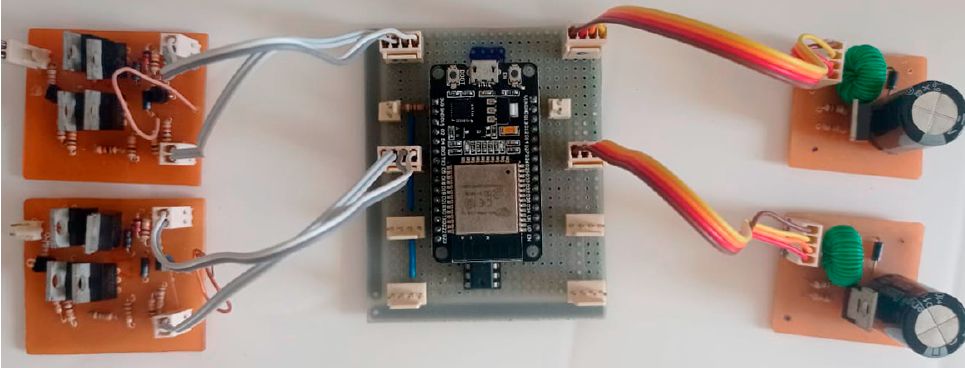
Figure 6. Electrostimulation built circuit. The figure shows the 2-channel circuit of the developed electrostimulator. On the left are two H-Bridge modules, in the center the processing module, and on the right, the boost